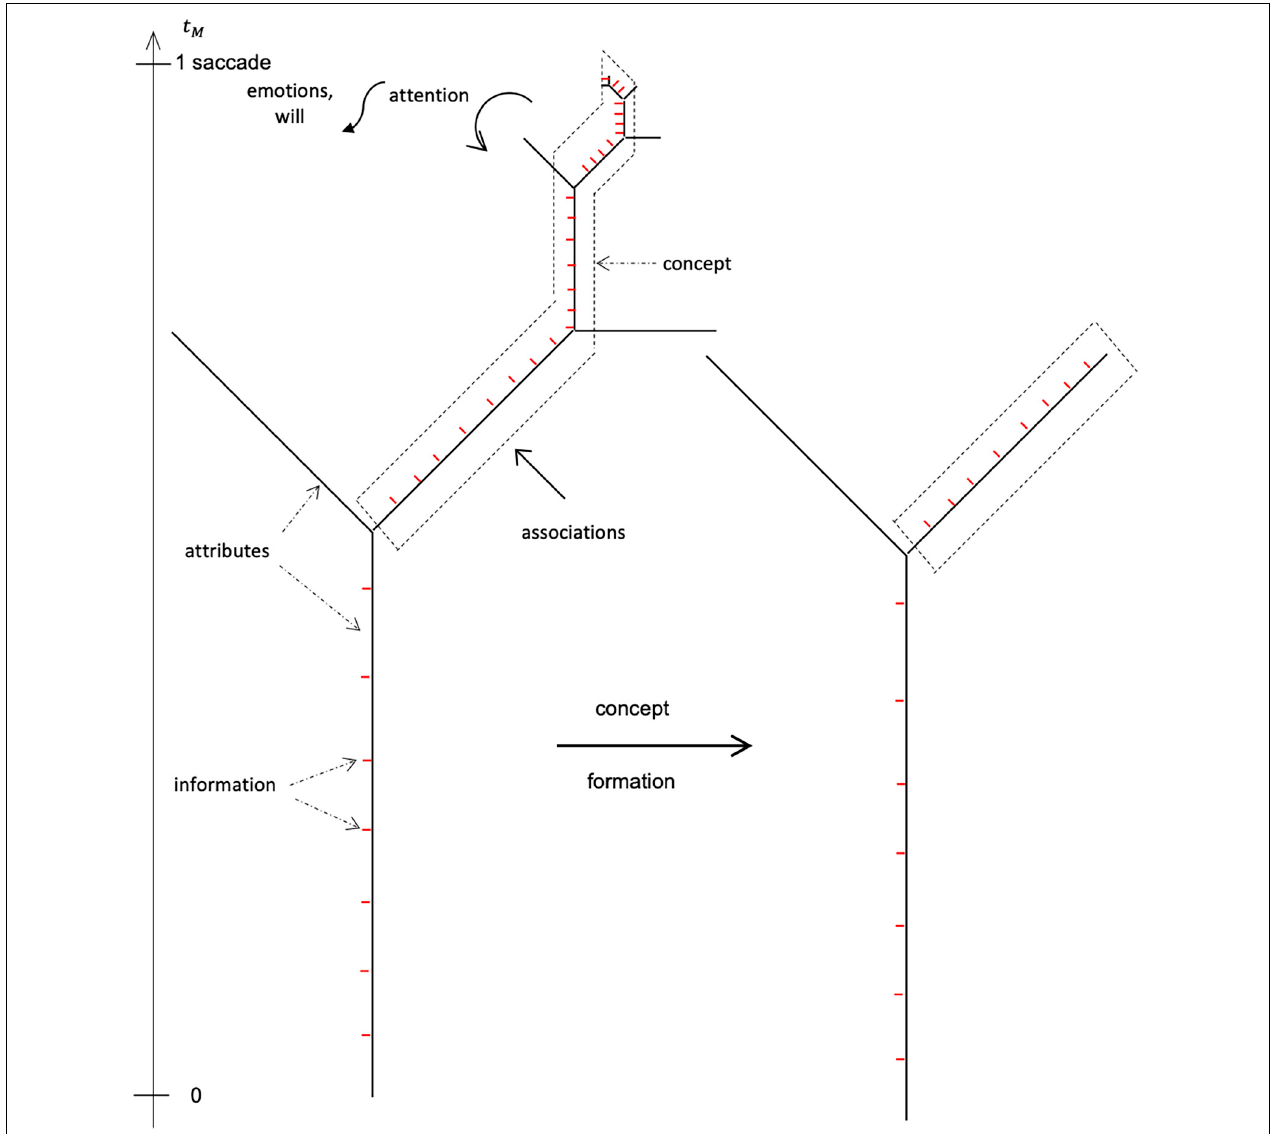
FIGURE 2 | Mechanics of information, concept, association (memory), attention, and volition in consciousness. Coordinate axes (attribute axes) are the stuff of consciousness (correlate of physical space) in the Mental Maxwell model. The maximum mental velocity c M = 7 ± 2 attributes / saccade is finite; therefore, only ∼ 7 attribute axes are laid down in consciousness within a mental time t M = 1 saccade (vertical axis). In this representation, the axes are not Euclidean, but connected in a tree. Some axes populate with information (correlate of energy; red) at the same rate, c M . A number of the populated axes amalgamate to begin forming a concept (correlate of a physical particle; dashed lines). The concept can exchange associations (momentum correlate) with other concepts in memory. Once a concept is formed, its axes can collapse into a single attribute. This prunes the consciousness tree effecting a decrease in information and in consciousness. Attention (force correlate; curved arrow) is the curvature of consciousness-time and can accelerate, decelerate, or divert concept formation. Will and the emotions (correlates of physical yank; wiggly arrow) accelerate attention itself. Since behavior is organized on the concept level, there are thus multiple inputs regulating transitions between concepts and consciousness in a moment-to-moment mental